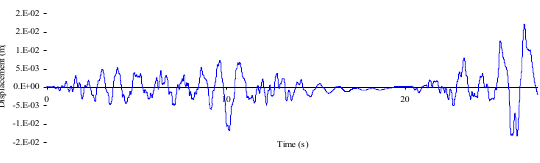
Figure 10. Horizontal displacement imposed at the top of the column.